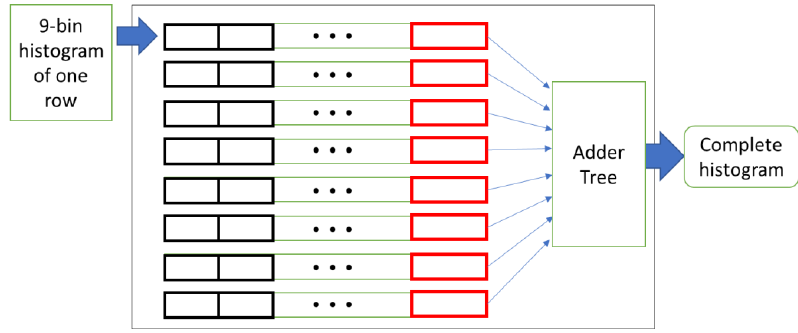
Figure 11. The block diagram of one-cell histogram buffers.